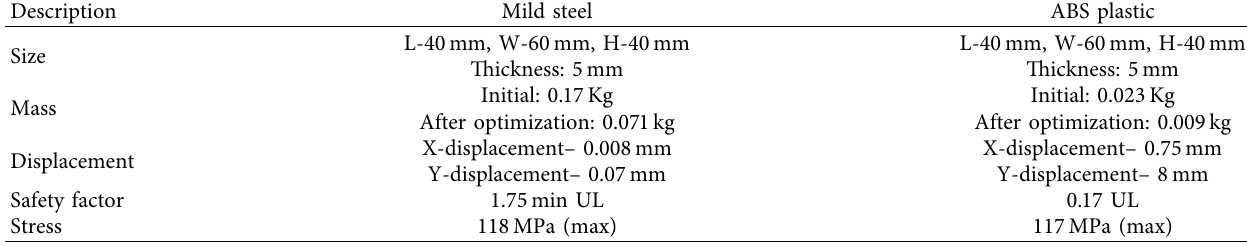
Table 2: Objective functions —steel plate vs ABS plastic.